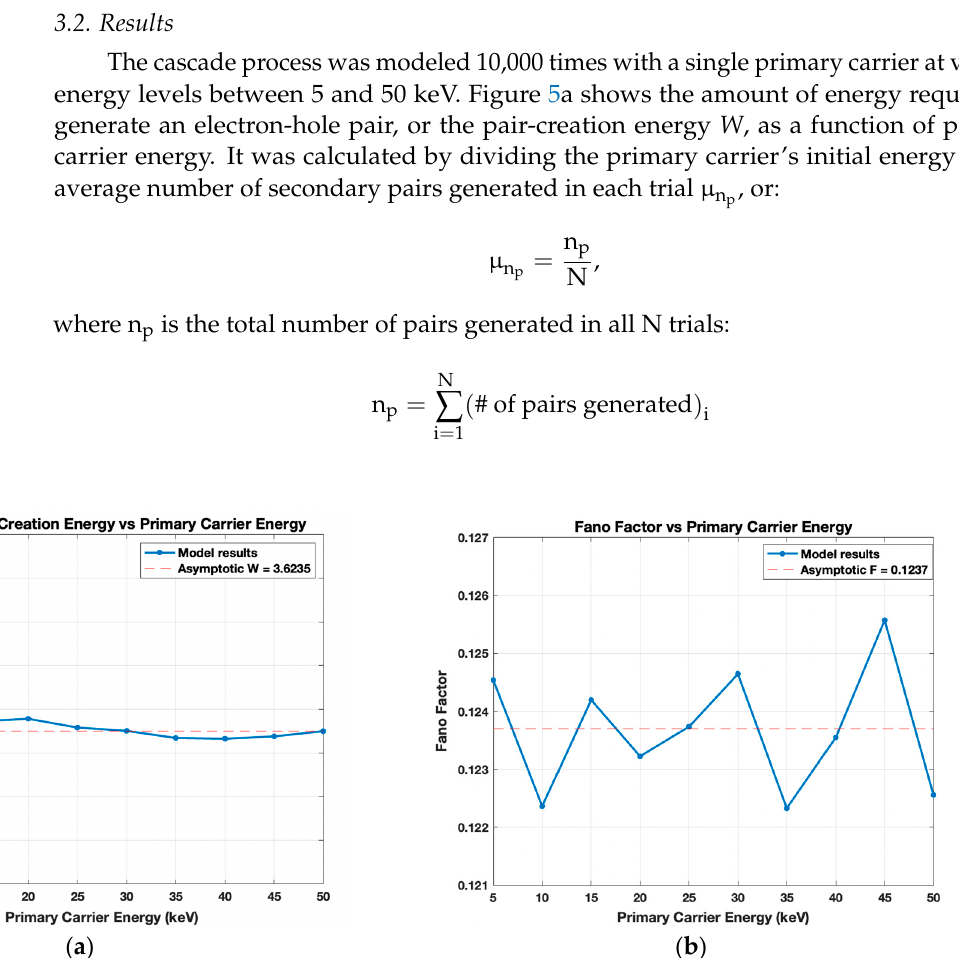
iN n = (cid:3533) (# of pairs generated) p